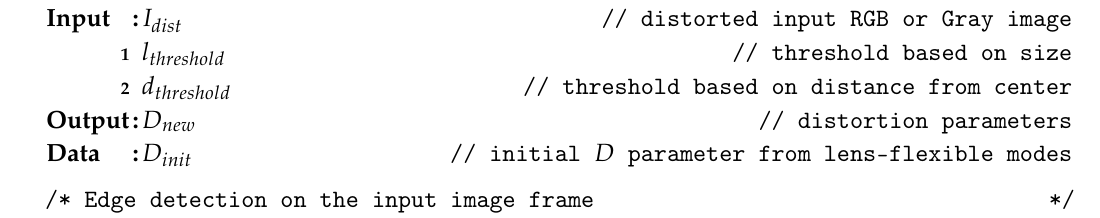
Algorithm 1: Straightness constraint loss and Distortion parameter